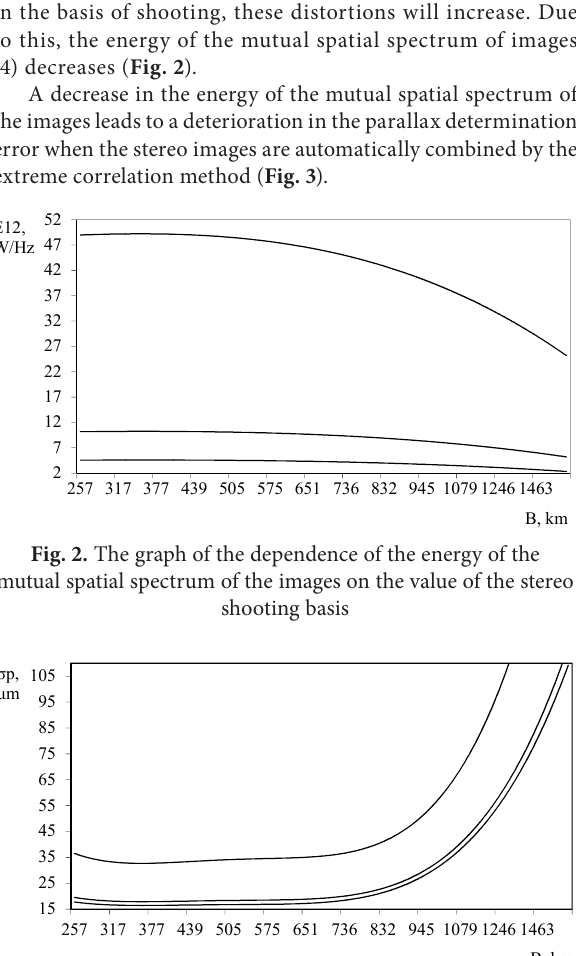
Fig. 3. The dependence of the parallax determination error on the value of the stereo shooting